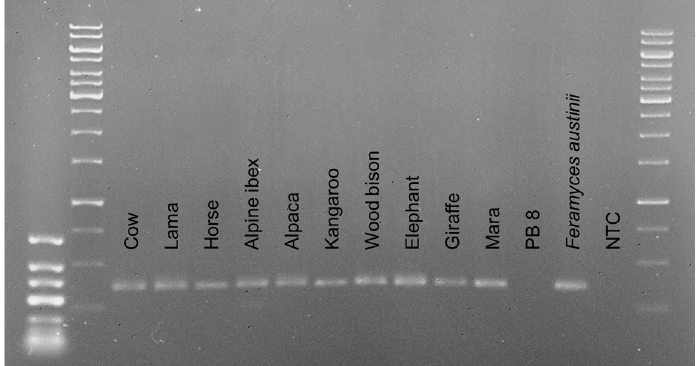
Figure 2. Agarose gel (1%) with amplicons of the D2 LSU subregion obtained from DNA extracts of feces of different herbivores. Amplicons generated with primer pair AGF-LSU-EnvS showed the expected length of approximately 350 bp. GeneRuler TM Low Range DNA Ladder (ThermoFisher) on the left, third and fourth bands 400 bp and 300 bp, respectively. GeneRuler TM 1 kb Ladder (Thermo Fisher) on the right, second to last bar 500 bp and last bar 250 bp. DNA of Feramyces austinii isolate DF1 was amplified as a positive control and DNA from digester sludge from a biogas plant without cattle manure input (PB 8) as a negative control. NTC = no template control.